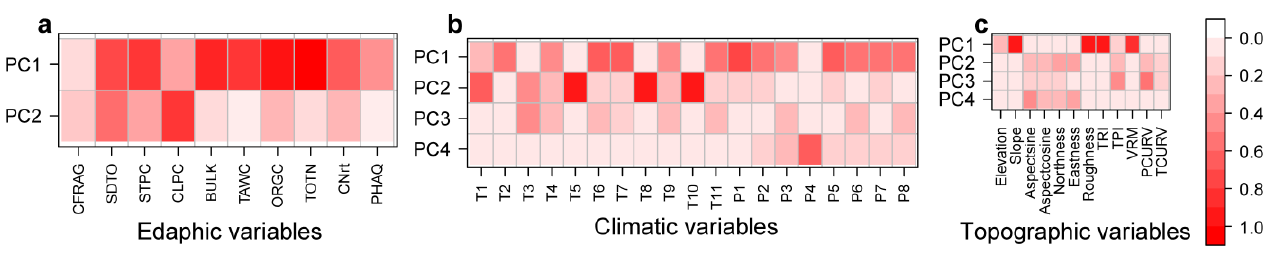
Figure A3. Relationship between aboveground biomass and two climatic attributes : ( a ): mean temperature during plant growing seasons (April – October; T G ), ( b ): accumulated precipitation during plant growing seasons (April – October; P G ). Data for all management such as fertilization and water were included.